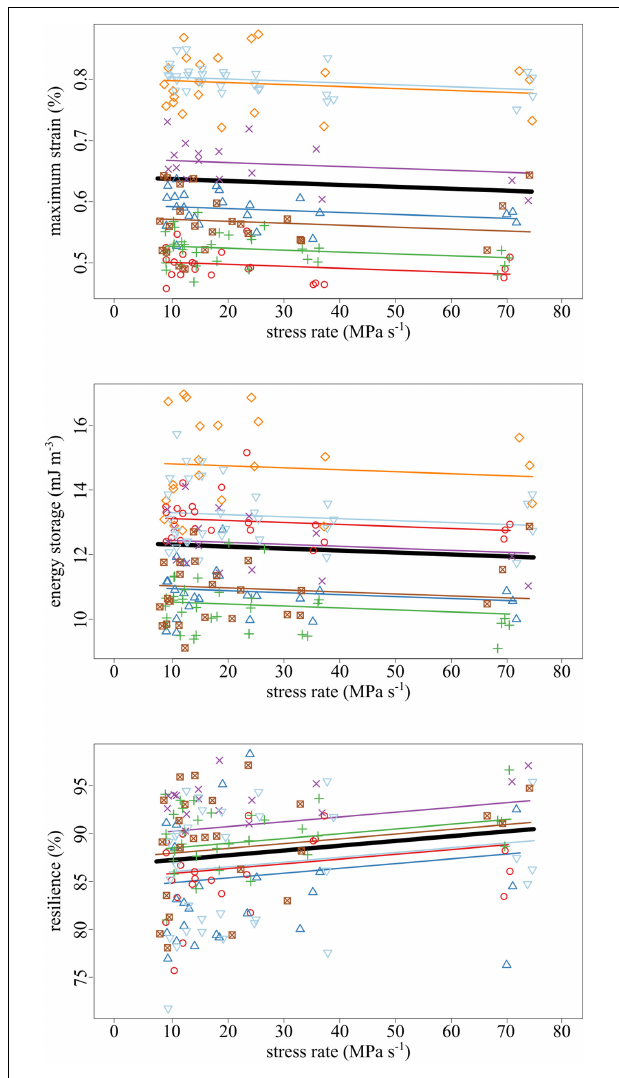
FIGURE 5 | As the stress rate of loading increased, both the maximum strain and strain energy storage decreased while the resilience increased. Data collected from the same tendon fascicle are represented by unique colors and symbols. A linear mixed-effects model was fit to the data to account for the hierarchy due to non-independence within replicates and samples. The thick black lines represent significant fixed effects of maximum strain ( p = 0.007), energy storage ( p = 0.040), and resilience ( p = 0.004) regressed against stress rate. Thin lines represent within- individual relationships and are colored identically to the raw data to which they